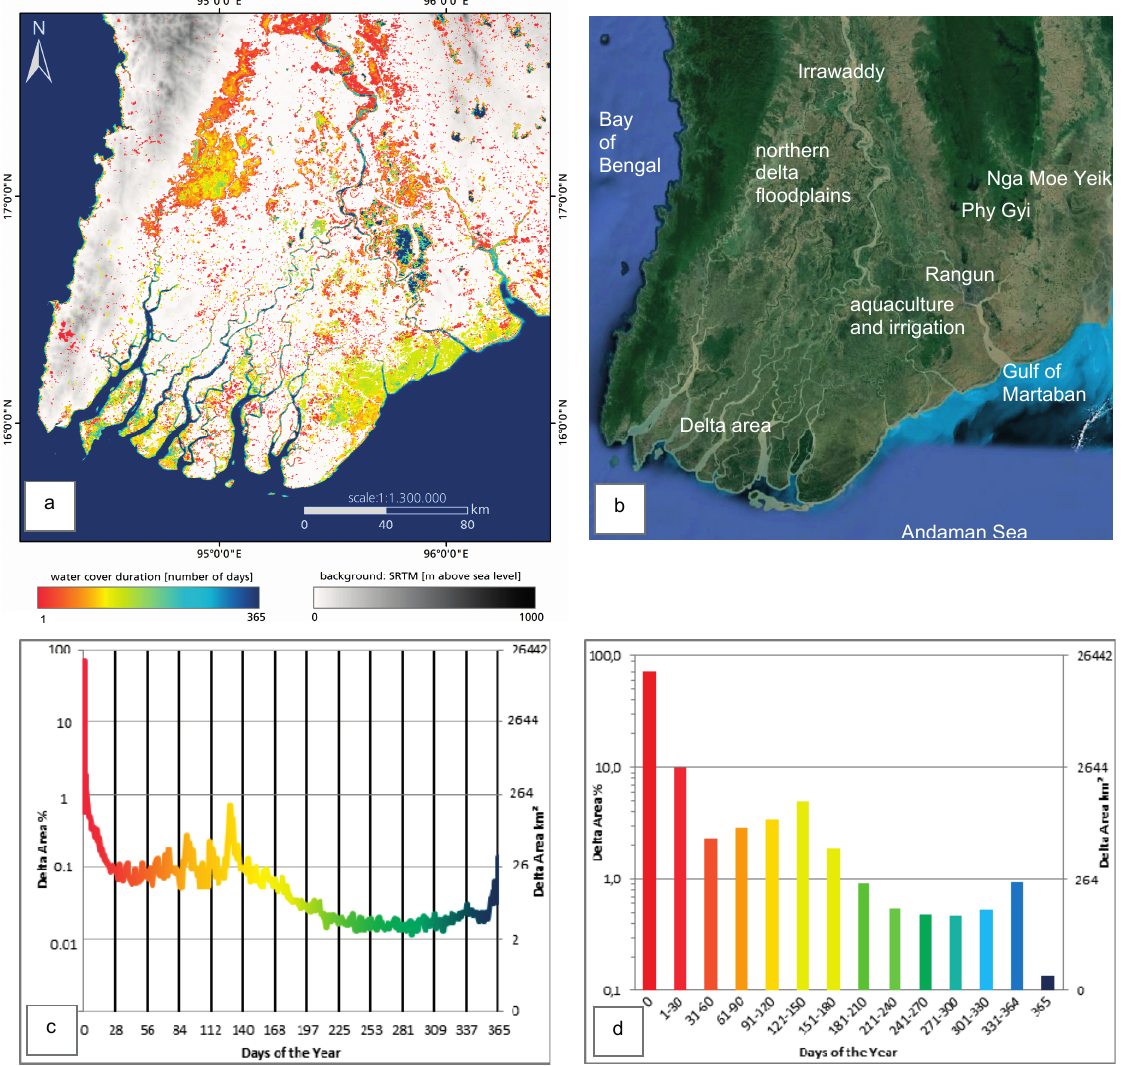
Figure 6. Intra-annual inundation patterns of the Irrawaddy Delta, Myanmar, derived from an annual time series of daily temporal resolution for the year 2013. ( a ) intra-annual inundation dynamics, ( b ) optical data for comparison, ( c , d ) quantitative analyses of inundation